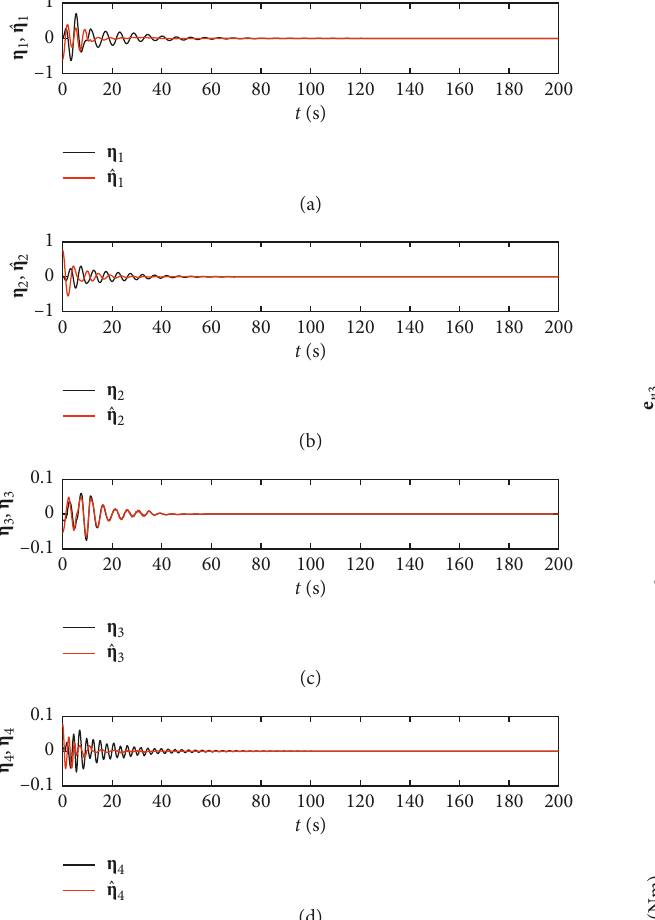
Figure 13: Time response of vibration displacements and their